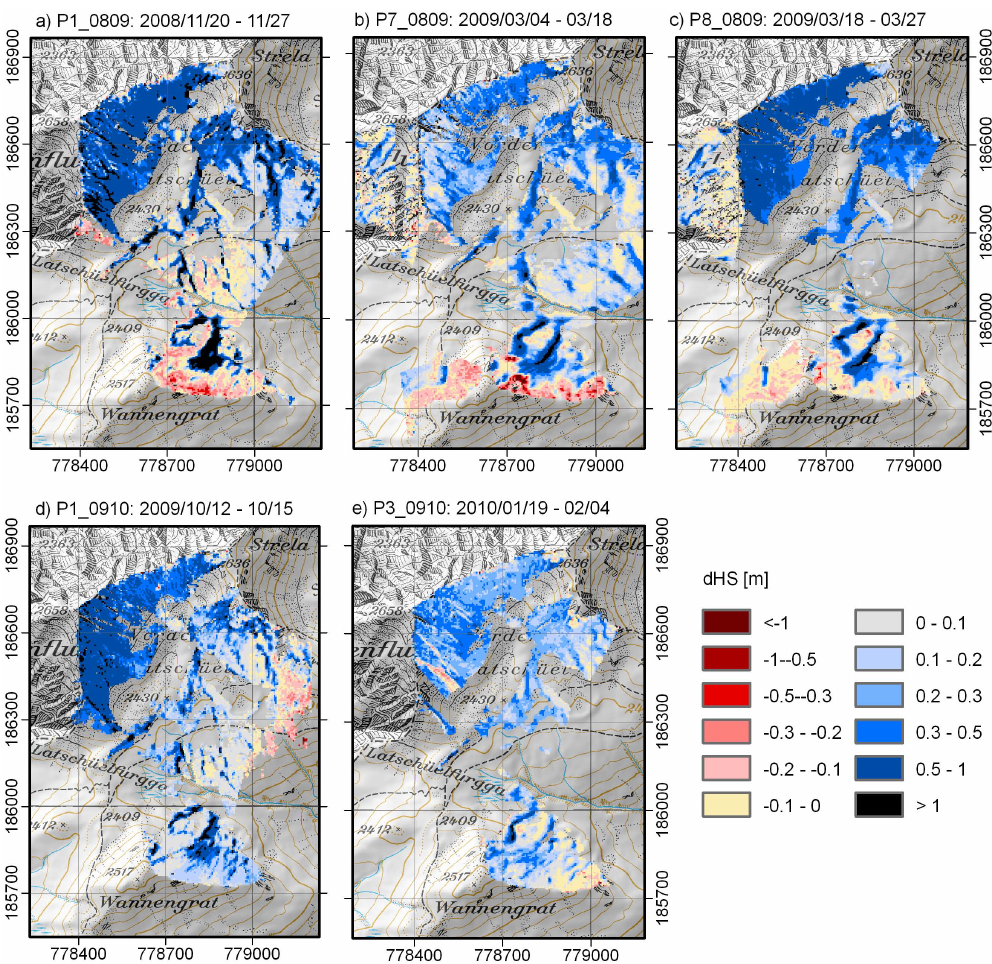
Fig. 6. Measured changes in snow depth (dHS) for the three major snow drift events in 2008/2009 and 2009/2010 during NW storms with precipitation. The x and y-axes give Swiss coordinates in meters. The horizontal grid resolution of snow-depth measurements were aggregated (mean) to a 5m grid. (basemap: Pixelkarte PK 25 ©2009 swisstopo